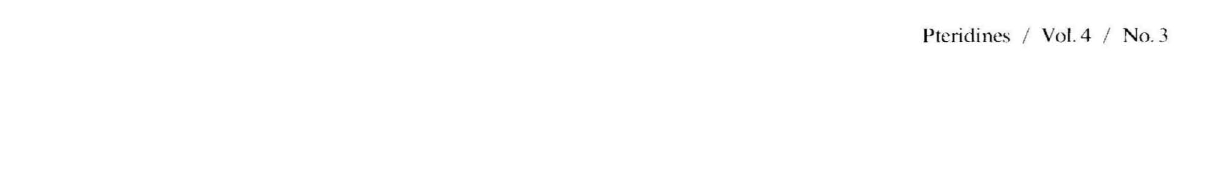
Figure 3. Course of serum neopterin concentrations (nmolll) "nd PASI-scores in patient 6 during therapy: decrease and increase of serum ncopterin concentrations correlated time-de pendently with severity of psoriasis measured by PASI-scores.